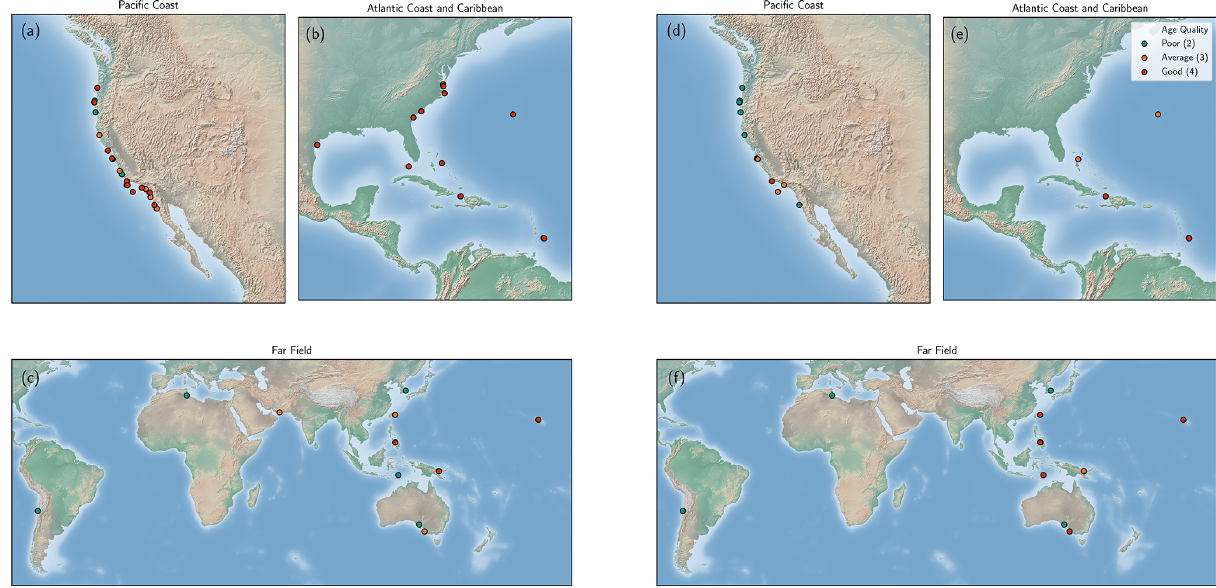
Figure 7. MIS 5a (a–c) and MIS 5c (d–f) sea level indicator chronology quality ratings atop the Matplotlib Basemap Shaded Relief map (Hunter, 2007). For the five Iranian subsites we plotted the lowest quality ratings of those listed in Tables 1 and